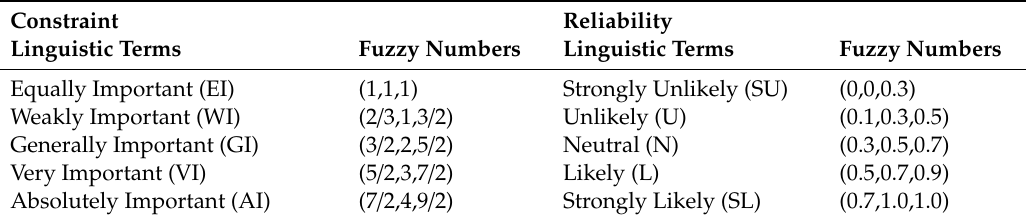
Table 2. The membership function of linguistic